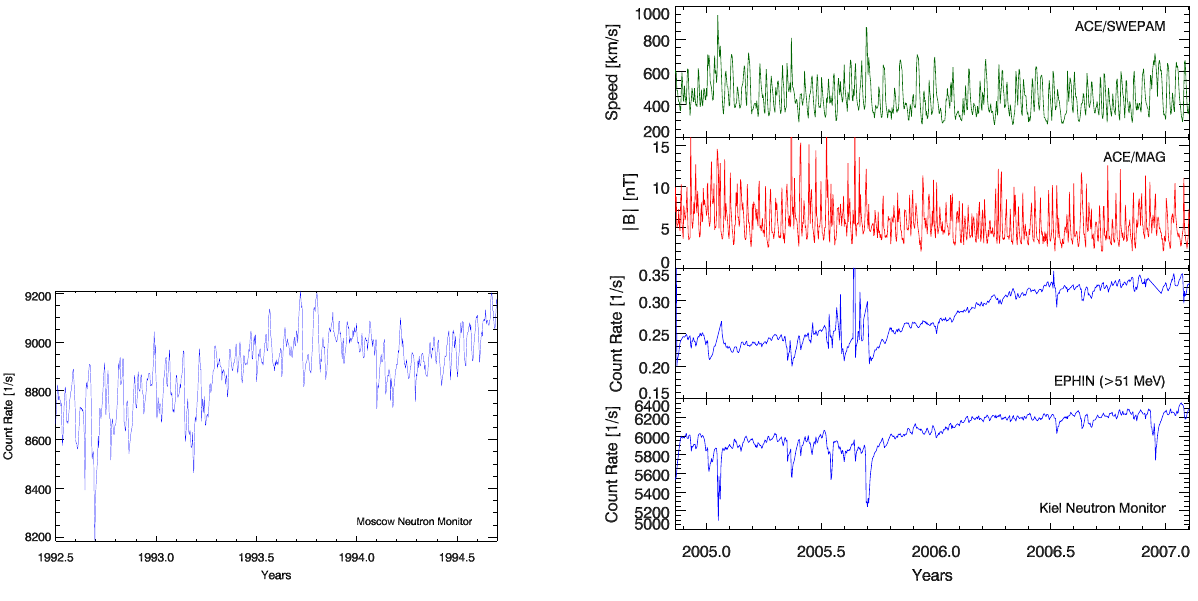
Fig. 8. The left panel the count rates of the Moscow Neutron Monitor in C22, the right panel shows the data displayed similar to Fig. 3 for the interval C23: from top to bottom the solar wind speed (SWEPAM), the magnetic field strength (MAG), the cosmic ray variation of > 51MeV particles (EPHAN), and the count rates of the Kiel Neutron Monitor.